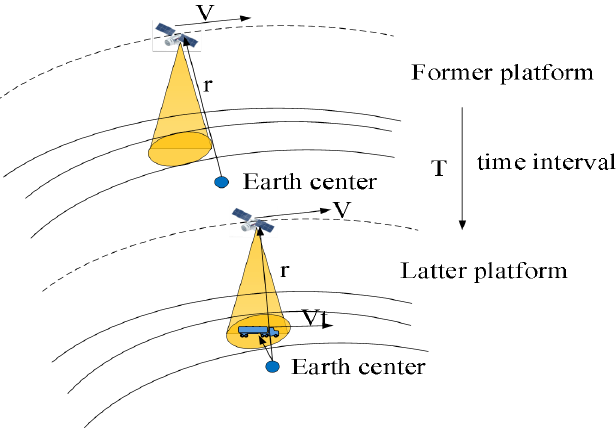
Figure 5. The geometric scene of forward and backward